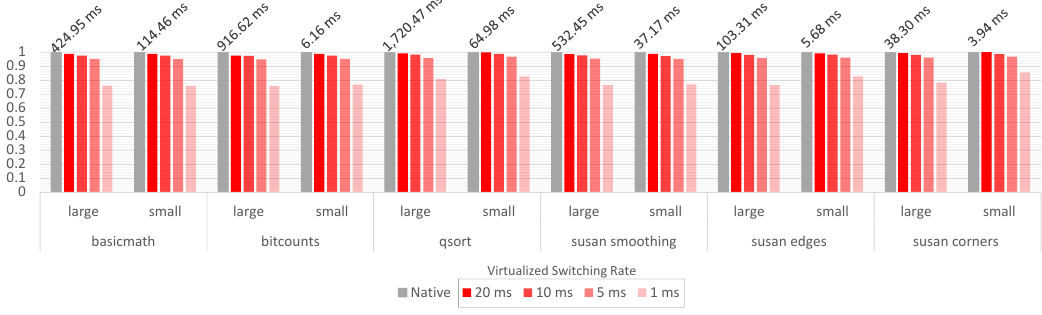
Figure 7. MiBench Automotive Benchmark results, comparing the native execution of a FreeRTOS guest against its virtualized execution with different